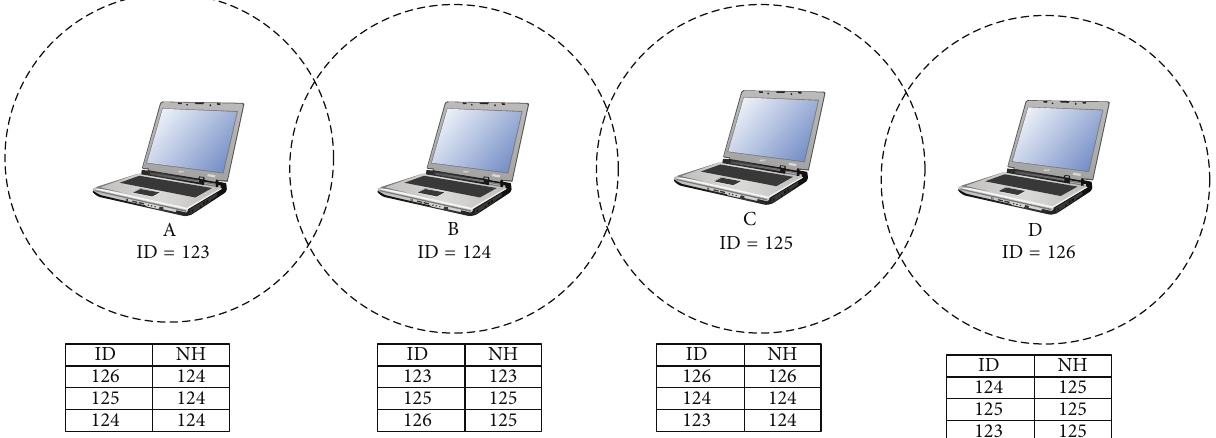
Figure 8: Identifier based path establishment in IDHOCNET.